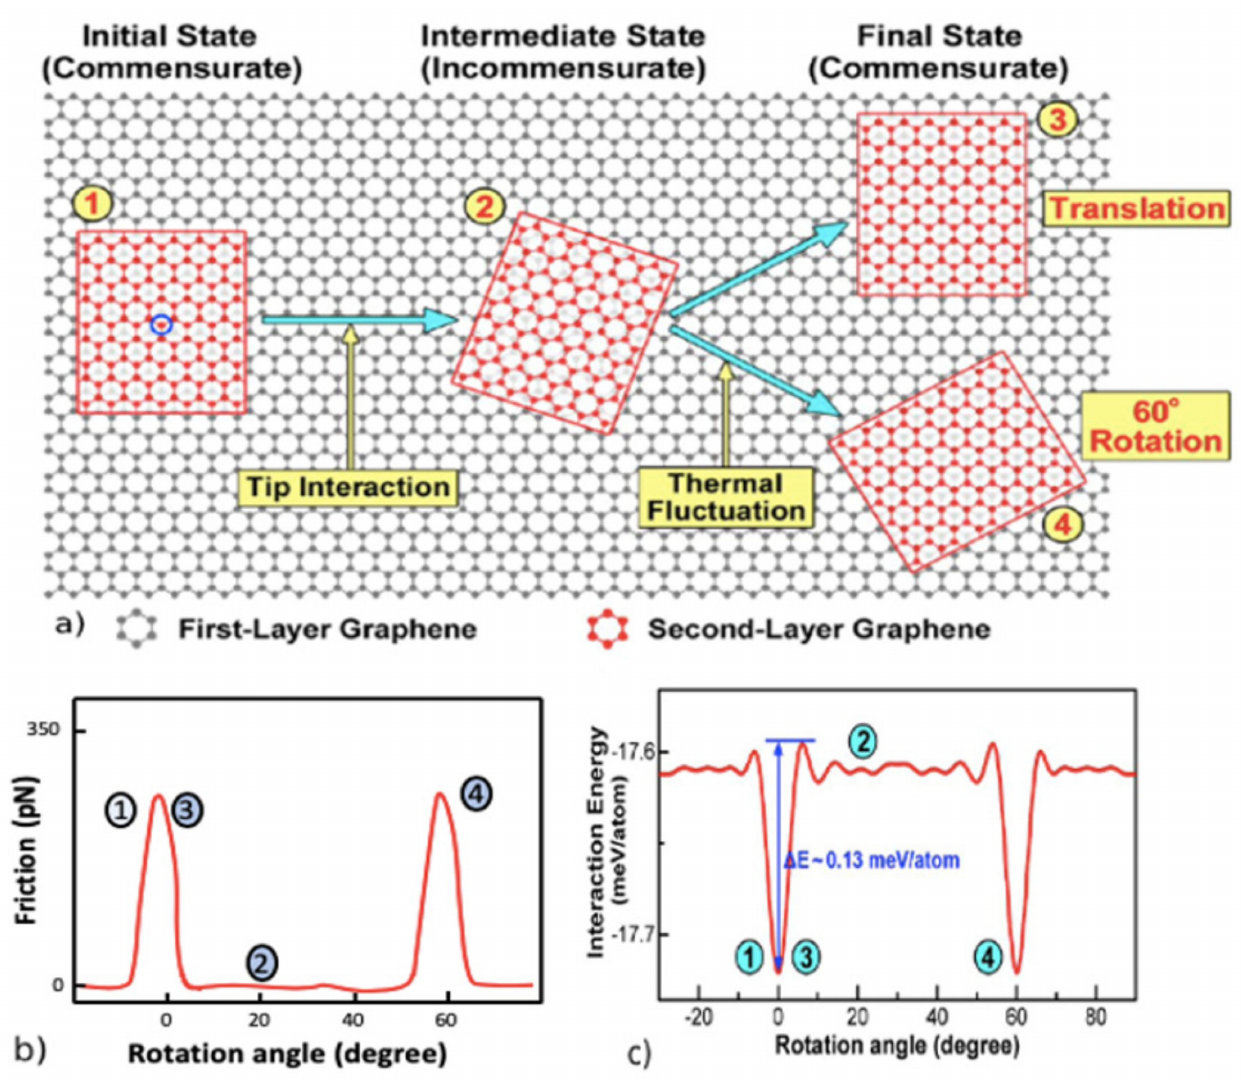
Figure 9. ( a ) Schematic of commensurate and incommensurate sliding of one graphene layer over another [71]; ( b ) variation of nanoscale friction with respect to the change in relative angle of rotation [69]; and ( c ) interaction energy as a function of rotation angle. Negative interaction energy signifies attractive forces and increase in friction increases